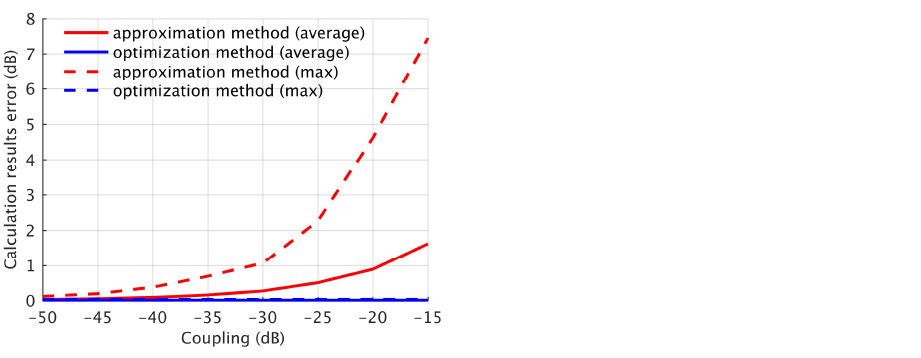
Figure 19. Comparison of coupling errors calculated by approximation method and optimization method.